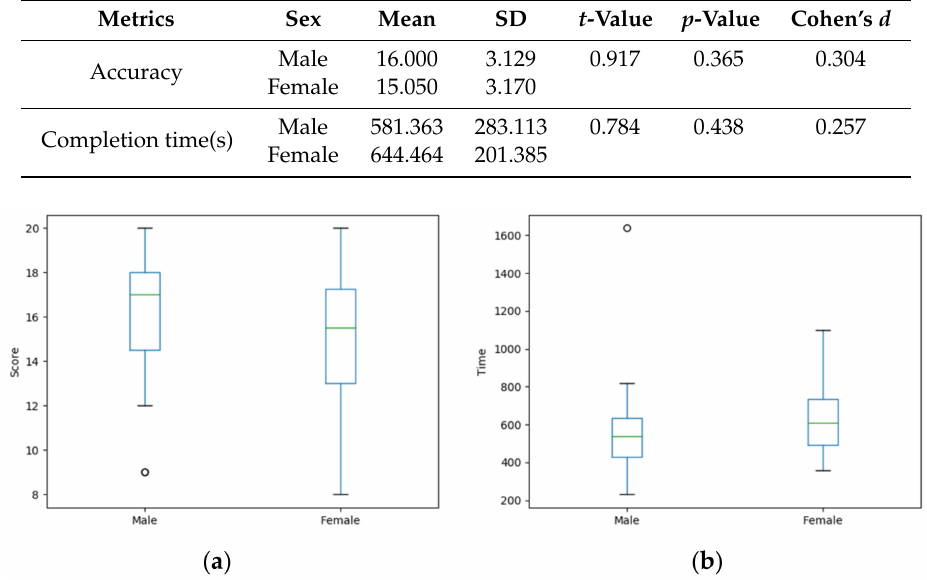
Figure 2. Accuracy ( a ) and completion time ( b ) of the male and female participants.